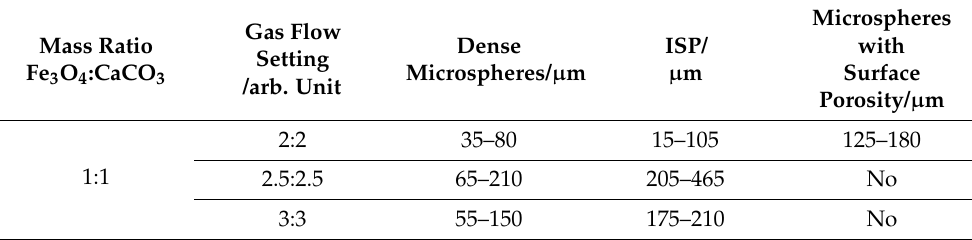
Table 4. Size range of fl ame spheroidised reaction products (dense microspheres, irregular-shaped particles (ISP), and microspheres with surface porosity), as a function of gas fl ow se tt ing.